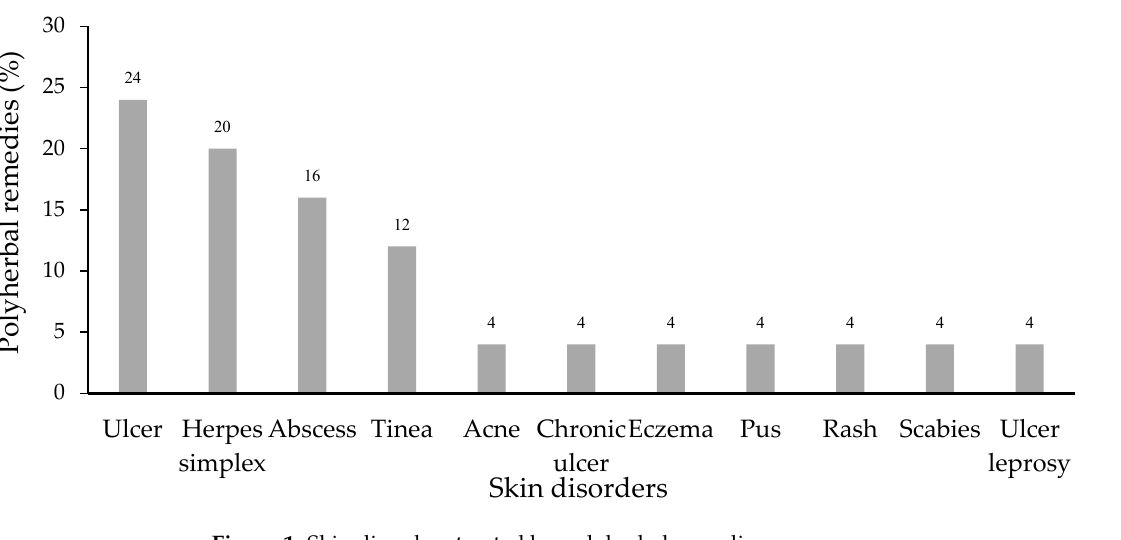
Figure 1. Skin disorders treated by polyherbal remedies.